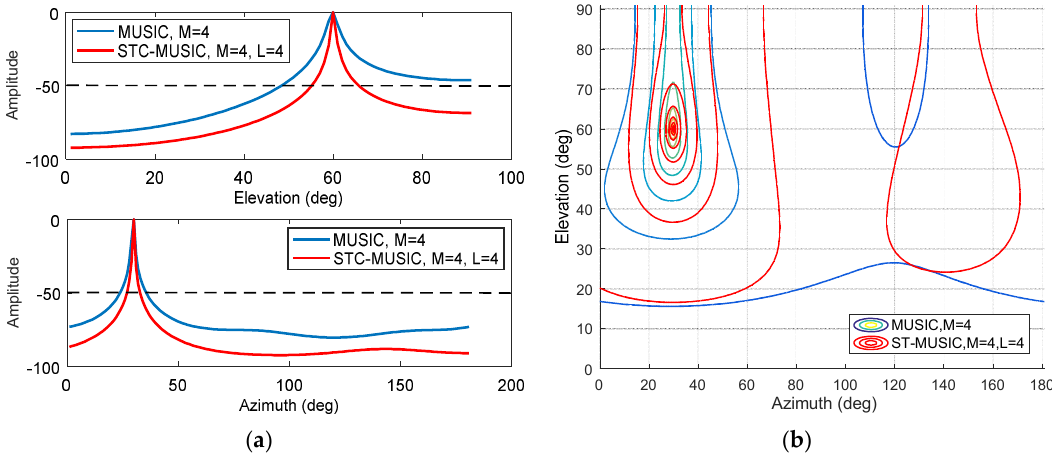
Figure 10. ( a ) Estimation results for elevation and azimuth obtained by MUSIC and STC-MUSIC algorithms (Top: The corresponding elevation angle spectrum function curves when the azimuthal angle is 30°; Bottom: The corresponding azimuthal angle spectrum function curves when the elevation angle is 60°); ( b ) Contour map of the spectral function.